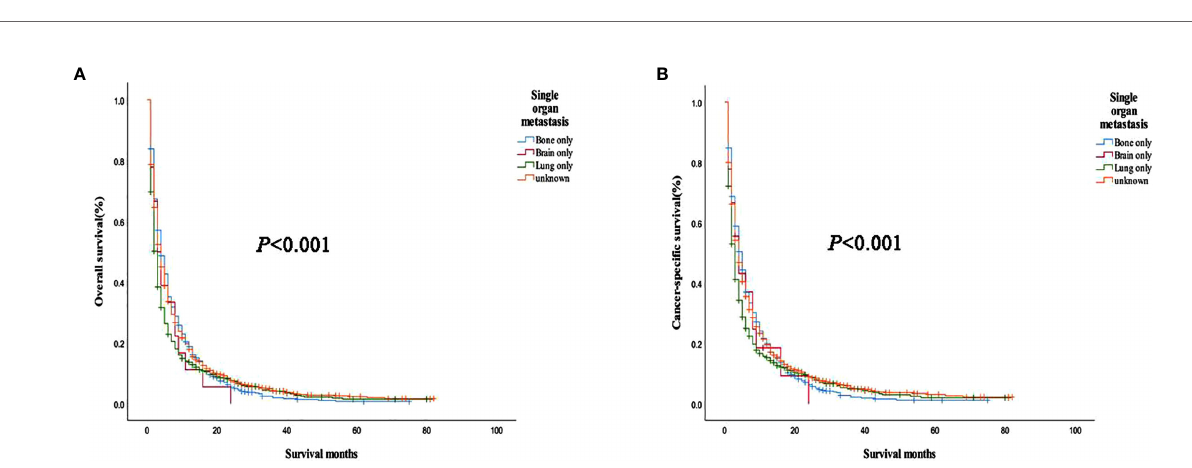
FIGURE 4 | (A) Overall survival and (B) cancer-speci fi c survival curves of different metastatic sites in a patient with single organ metastasis.